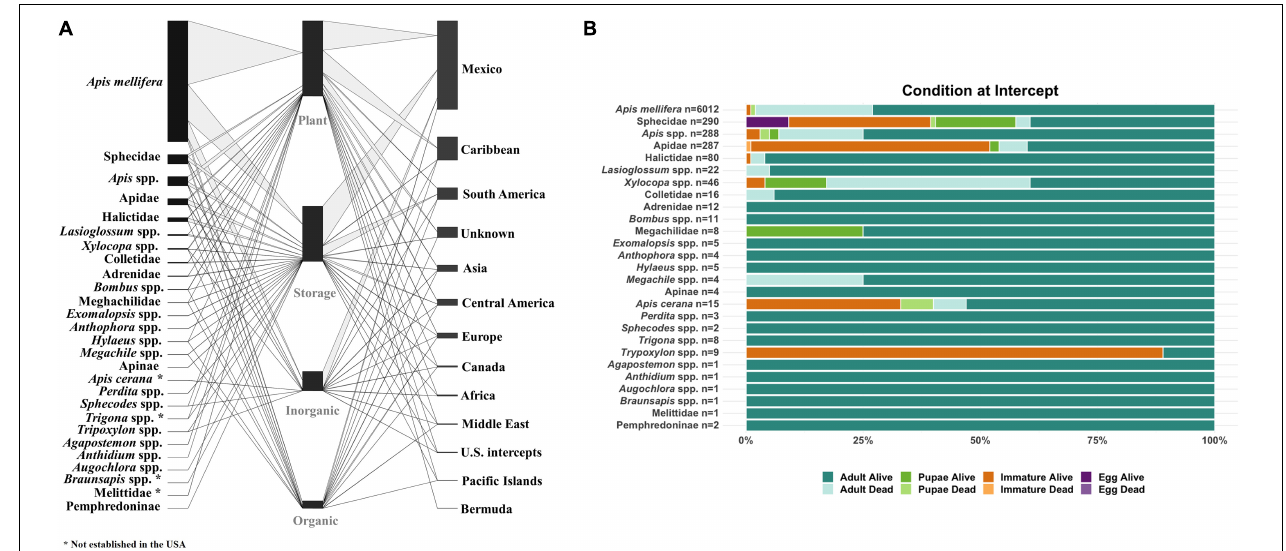
FIGURE 1 | Apoidea intercepts at United States borders (2001–2021), adapted from APHIS’s Agricultural Quarantine Activity System (AQAS) data. (A) The bee or wasp species (left column) arrived on the material noted (middle column) from the region noted (right column). (B) The life stage and condition (dead or alive) of the individual that was